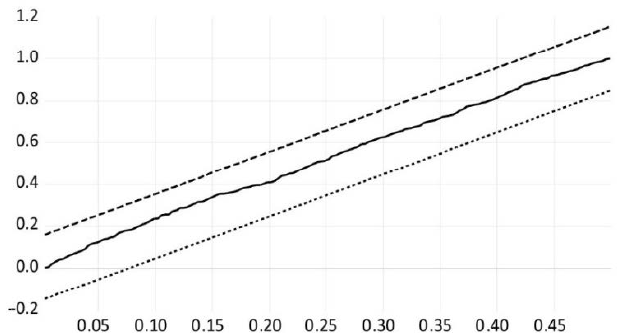
Figure 3. Spectral tests: Normalized integrated spectrum for Japan. Note: This test evaluates the null hypothesis that the data are stationary (white noise). It is based on the normalized integrated spectrum with the following statistic: U p = , where I ( ω ( i )) is the i th maximum. The test statistic (vertical axis) is plotted against its frequency (horizontal axis). If the deviations of the statistic from the p /( n /2) line do not exceed ± a 2/ n , the null will not be rejected, where a is set equal to 1.36 for 95% confidence.